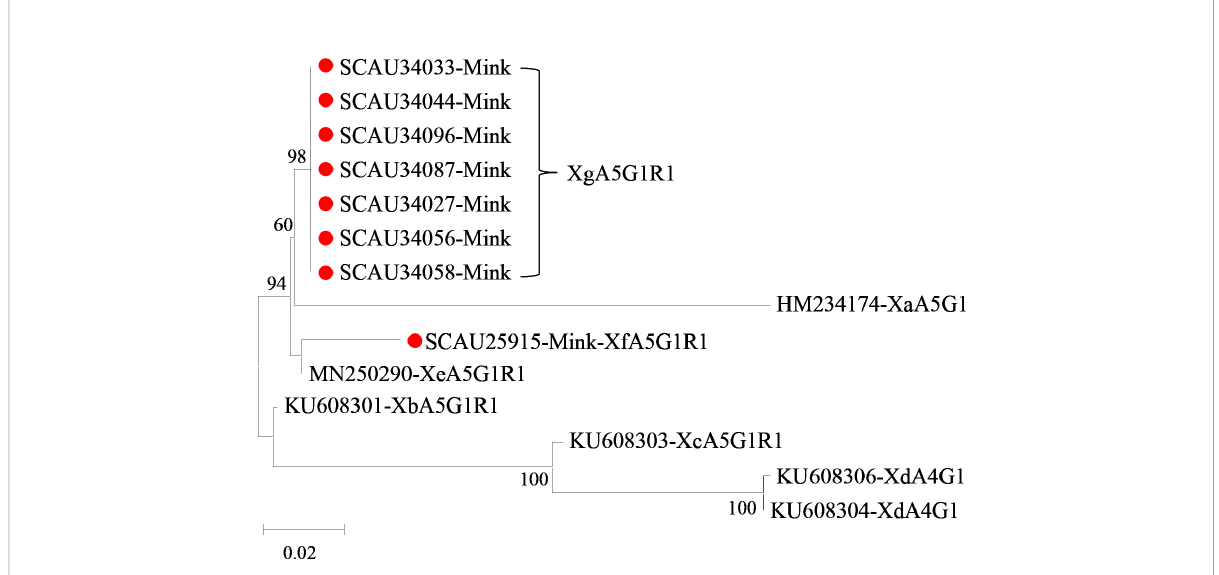
FIGURE 3 Phylogenetic relationship among seven subtype families (Xa-Xg) of Cryptosporidium mink genotype based on the maximum likelihood analysis of the partial gp60 gene using the general time-reversible model for the calculations of substitution rates. Bootstrap values greater than 50% from 1,000 replicates are displayed. Samples detected in minks from this study are indicated with red